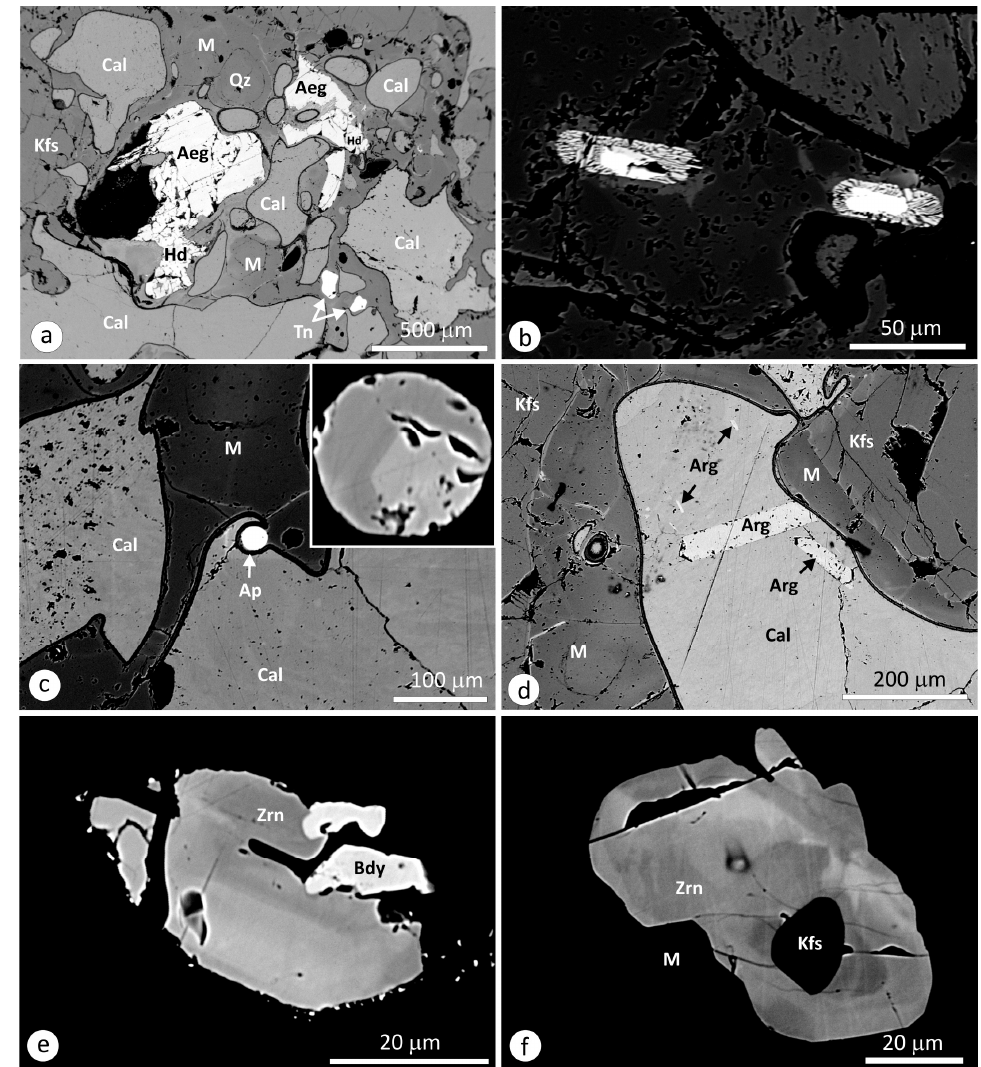
Figure 4. Back-scattered electron images of accessory minerals in carbonatite-syenite xenolith HA-8 from Hajná č ka diatreme. ( a ) Microscopic view documenting rounded calcite blebs embedded in a silicate glass matrix and partly resorbed grains of titanite and aegirine replaced by hedenbergite. ( b ) Coronal rutile replacing resorbed ilmenite crystals. ( c ) Apatite globule embedded within silicate glass, partly encompassed by carbonate. Enlarged view in the inset documents a growth zoning of the resorbed crystal. Deformation of calcite around the globular apatite testifies to the carbonate liquid. ( d ) Aragonite crystals grown from the interface between silicate and carbonate phases. One of the two larger aragonites was detached from the original position during the carbonate liquid movement. Perfect euhedral shapes indicate the equilibrium crystallization from the carbonatite liquid. ( e ) Zirconolite–baddeleyite aggregate in the interstitial glass matrix. ( f ) Domain-zoned zirconolite embedded in silicate glass. Brighter domains are enriched in Th and REE, whereas less